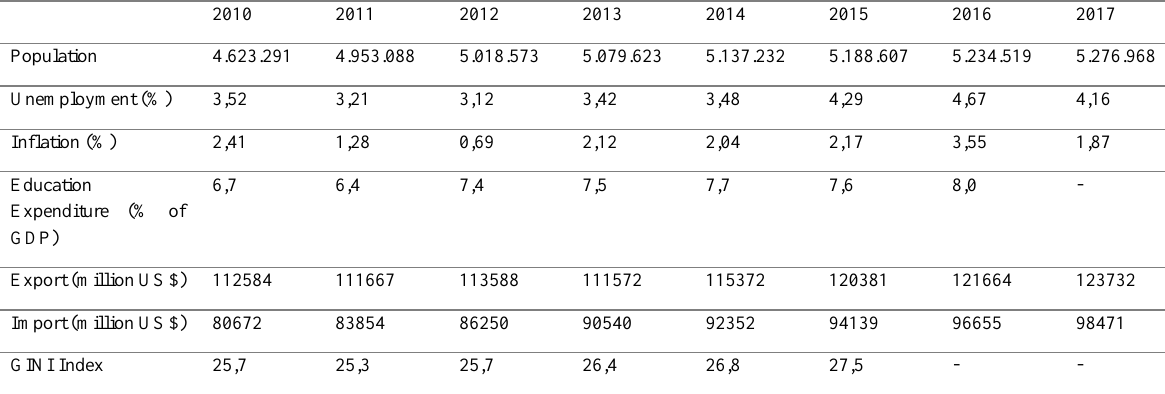
Table 4: Some Important Indicators for the Norwegian Economy